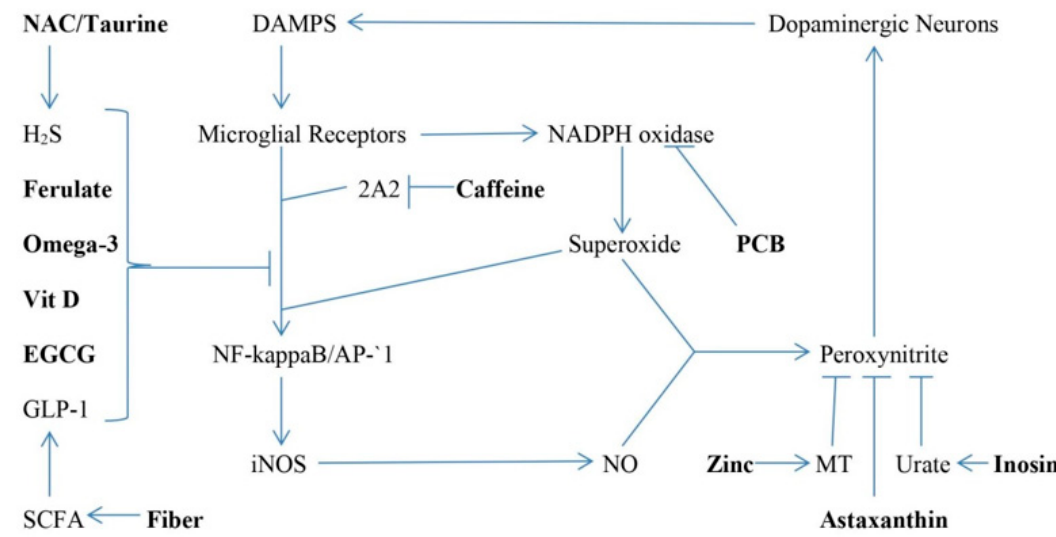
Figure 1. Vicious cycle of microglial activation and dopaminergic neuron death in pathogenesis of Parkinson’s disease (PD), depicting nutraceutical interventions that may provide